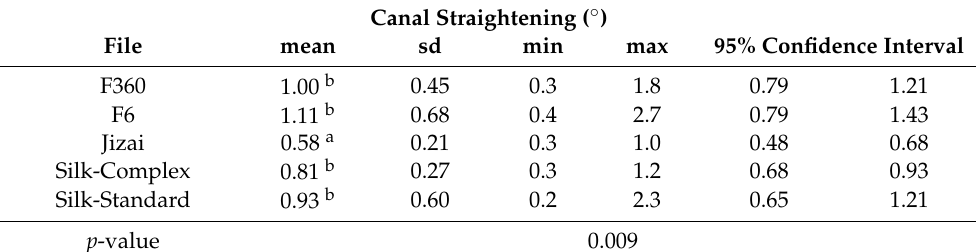
Table 2. Degree of canal straightening ( ◦ ) after preparation with the different instruments ( n = 20/group). Given are the means with standard deviation (sd), the minimum and maximum values, and the 95% confidence interval. Values with the same letters were not statistically different at p = 0.05.